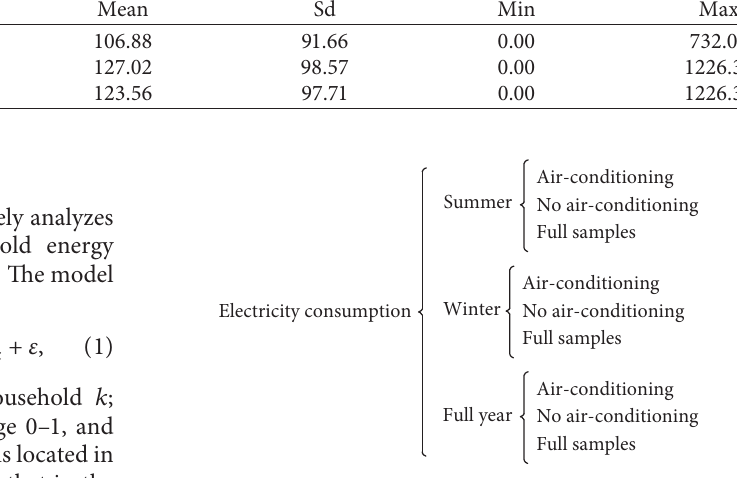
Figure 2: Nine kinds of situations for regression analysis,